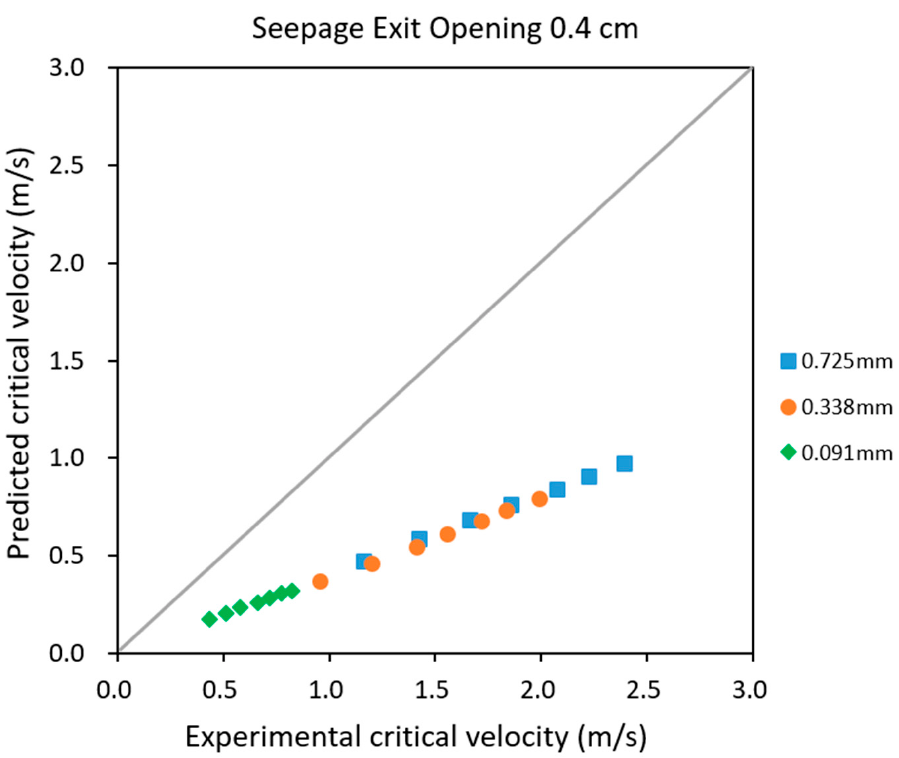
Figure 8. Comparison between predicted and experimental results with the seepage exit opening of 0.4 cm.